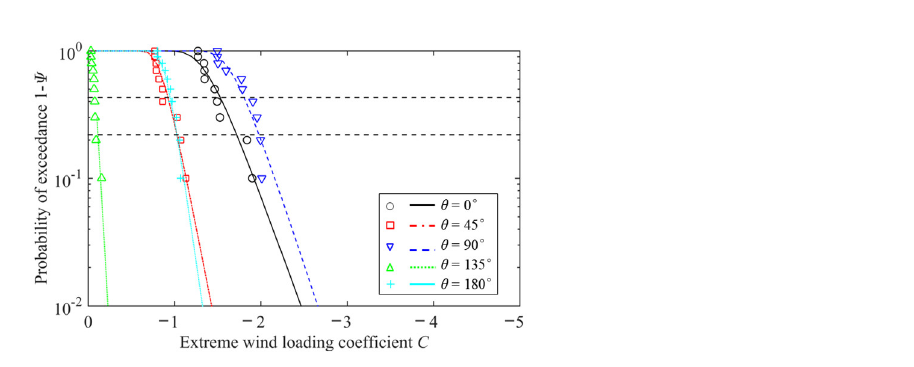
Figure 5. Probability distribution of extreme wind loading coefficients of Module (4-2) for different wind directions.